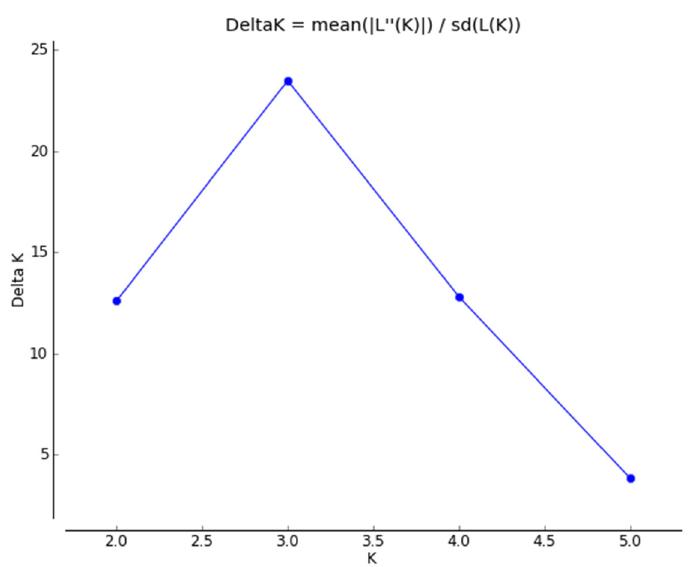
Figure 3. Results from Structure Harvester analysis to reveal the most likely value of K based on STRUCTURE results.